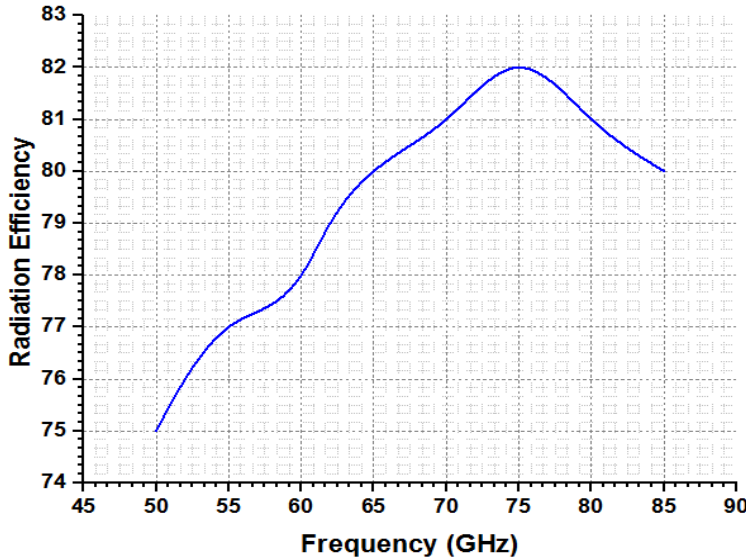
Figure 11. Radiation efficiency vs frequency estimations.